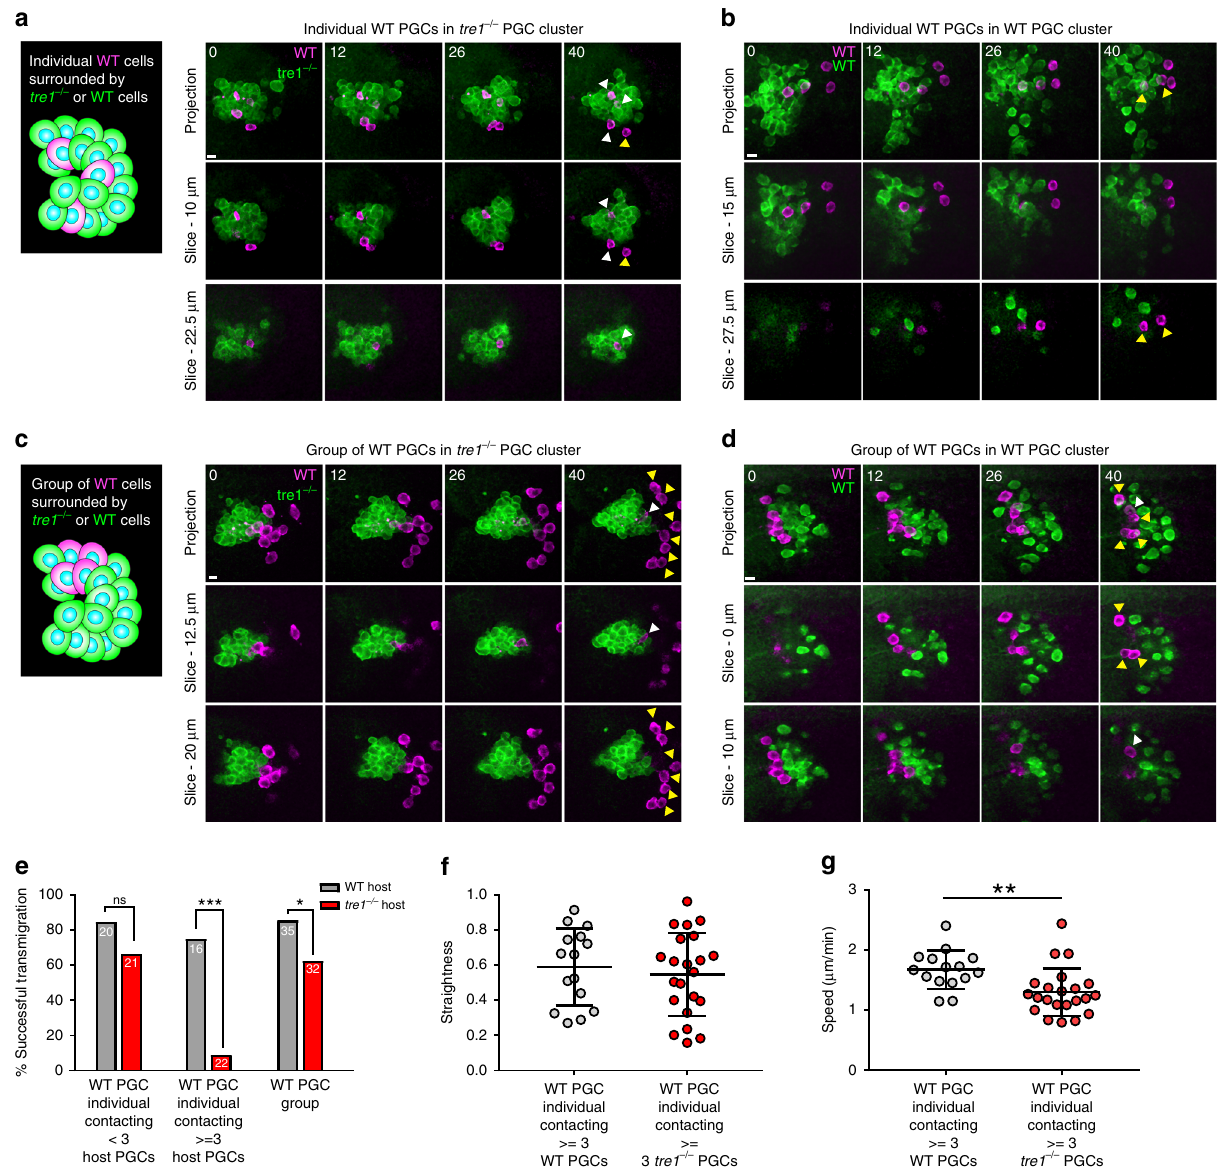
Fig. 7 Coordination is necessary for ef fi cient cluster dispersal. Two-photon timelapse imaging of representative transplanted individual WT PGCs into tre1 − / − ( a ) or WT ( b ) hosts or transplanted group of WT PGCs (De fi ned by 3 or more contacting PGCs) in tre1 − / − ( c ) or WT ( d ) hosts. Transplanted PGCs are marked with lifeacttdTomato while host PGC clusters express Moesin-actin binding domain (ABD)-GFP. Top row of images is a maximum intensity projection while bottom two rows show a Z slice at the indicated depth from the top of the cluster. White arrows mark PGCs which have not detached from the cluster while yellow arrows mark PGCs which have detached and transmigrated. Representative images are from n = 22 embryos in ( a , c ) and n = 14 embryos in ( b , d ). Scale bars, 10 μ m. ( e ) Quanti fi cation of successful transmigration events from transplanted individual WT PGCs (left and middle set of columns) and WT PGC groups (right set of columns). Different hosts are color coded. The number of PGCs in each group is indicated on the bars taken from n = 14 WT host embryos and n = 22 tre1 − / − host embryos. Statistical comparisons are from a Fisher ’ s exact test with p < 0.0001 in the central comparison and p = 0.0478 in the comparison on the right. *** p < 0.001 and * p <0.05. Quanti fi cation of straightness ( f ) and speed ( g ) of transplanted WT PGCs contacting > = 3 WT ( n = 15 from 14 embryos) or tre1 − / − PGCs ( n = 22 PGCs from 22 embryos). Data are presented as mean values + / – SD. Statistical comparisons are from a Mann-Whitney test in ( g ) with p = 0.0021. ** p < 0.01. Source Data from ( e – g ) is provided as a Source Data fi